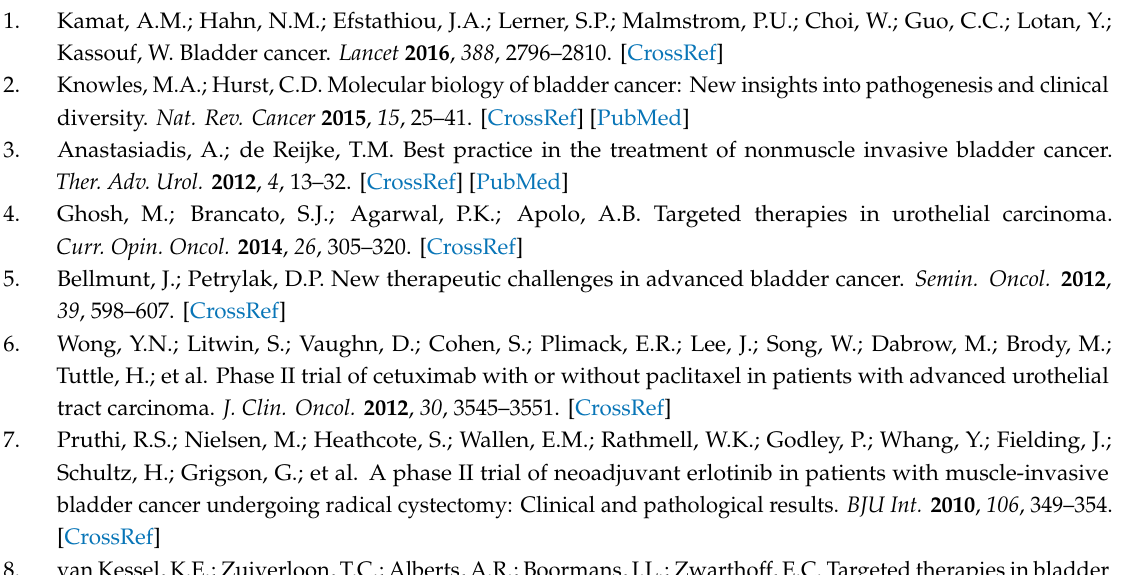
Figure S7I: Cell growth, proliferation and apoptosis related proteins, Figure S7J: Metabolism signaling related proteins, Figure S7K: Blood metabolism related proteins, Figure S7L: DNA metabolism and Damage repair related proteins, Figure S7M: Transporter related proteins, Figure S7N: Cell membrane, skeletal and golgi related proteins, Figure S7O: Tissue structure and adhesion related proteins, Figure S7P: Cell migration related proteins, Figure S7Q: Cell vesicle tra ffi c / formation signaling related proteins, Figure S7R: Neuroscience-nerve system regulation signaling-related proteins, Figure S7S: Virus function related proteins, Figure S7T: Cardiovascular and heart function related protein, Figure S7U: Eyes function related proteins, Figure S7V: Protein folding correction relevant chaperonin family proteins, Figure S7W: Nuclear pore complex (NPC) related proteins, Table S1: The original data (results) set derived from the Proteomics analysis of HT1376 versus UMUC3 with and with FL118 treatment for 24 h and 48 h, Table S2: All Kras signaling transduction network-relevant protein molecules resulted from the Proteomics analysis of HT1376 versus UMUC3 with and with FL118 treatment for 24 h and / or 48 h, Table S3: Kras network-relevant proteins that were downregulated in UMUC3 cells but were upregulated or have no changes in HT1376 cells after FL118 treatment for 24 h and / or 48 h, Table S4: Kras network-relevant proteins that were upregulated in UMUC3 cells but were downregulated or roughly have no changes in HT1376 cells after FL118 treatment for 24 h and / or 48 h, Table S5. Kras signaling pathway-relevant proteins (I), Table S6. Kras signaling pathway-relevant proteins